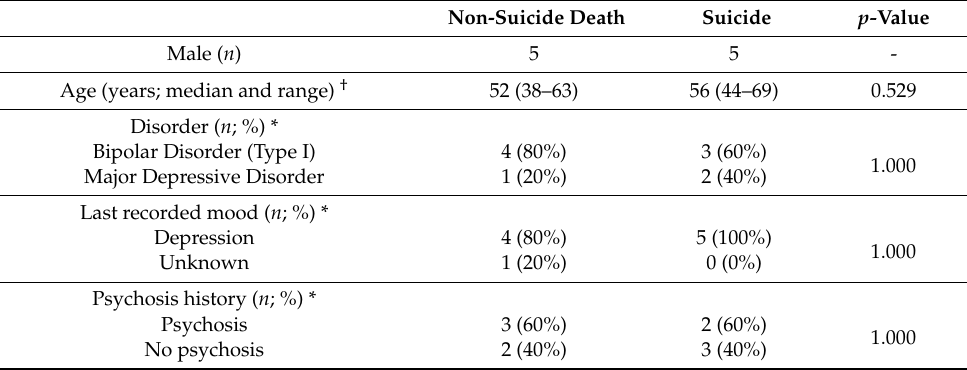
Table 1. Subject demographics, clinical, and tissue-related